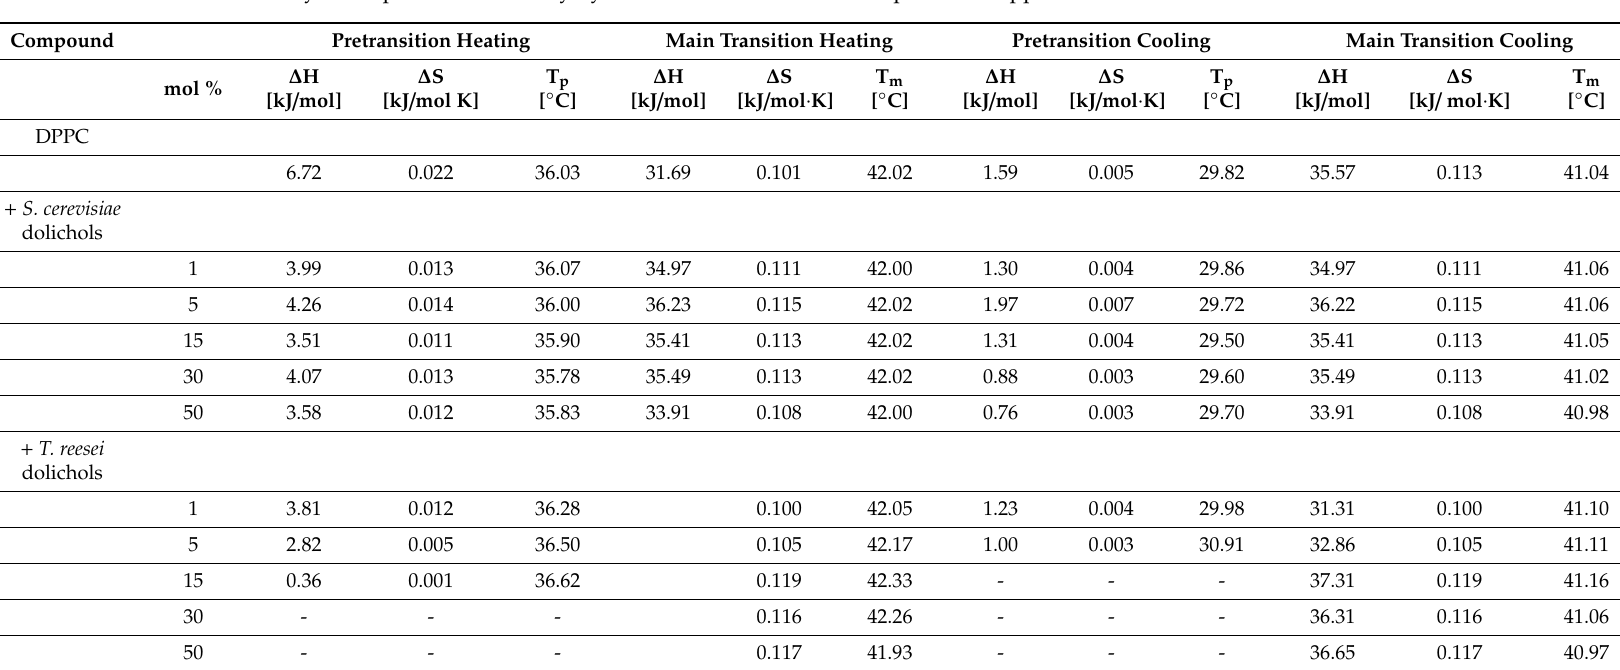
Table 4. Thermodynamic parameters of fully hydrated multilamellar DPPC liposomes supplemented with S. cerevisiae or T. reesei